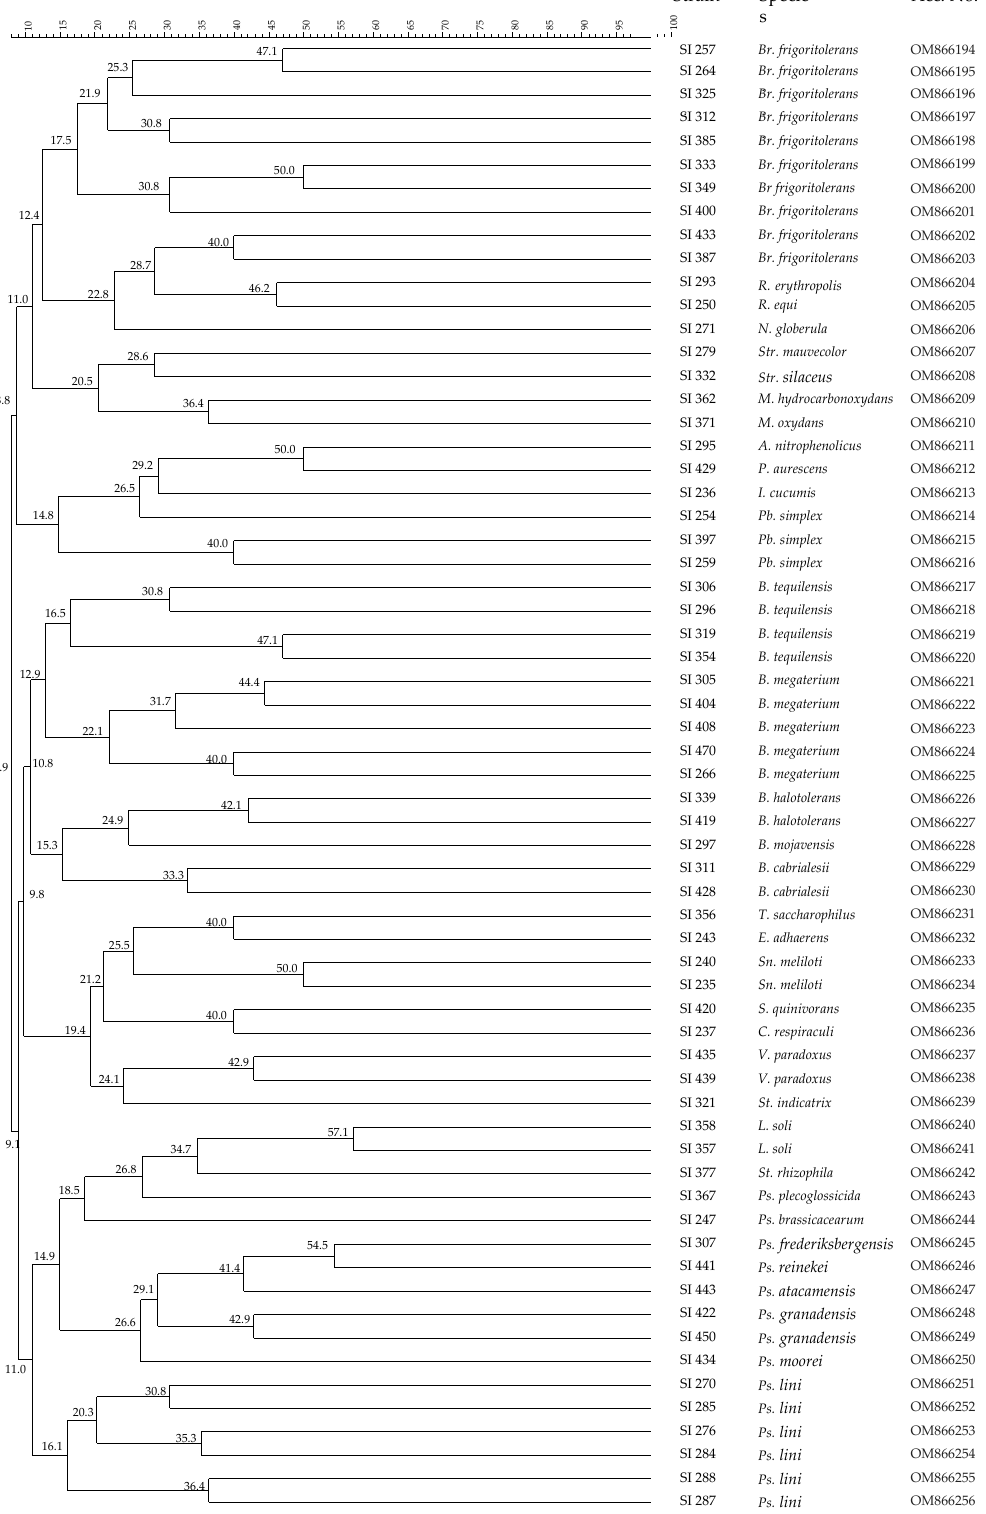
Figure 3. Dendrogram obtained from combined RAPD-PCR patterns generated with three primers (M13, AB106 and AB111) of the dominant bacteria identified from anthropogenic soils. Abbreviations: A., Arthrobacter ; B., Bacillus ; Br., Brevibacterium ; C., Cupriavidus ; E., Ensifer ; I., Isoptericola ; L., Lysobacter ; M., Microbacterium ; N., Nocardia ; P., Paenarthrobacter ; Pb., Peribacillus ; Ps., Pseudomonas ; R., Rhodococcus ; S., Serratia ; Sn., Sinorhizobium ; St., Stenotrophomonas ; Str., Streptomyces ; T., Terribacillus ; V., Variovorax .